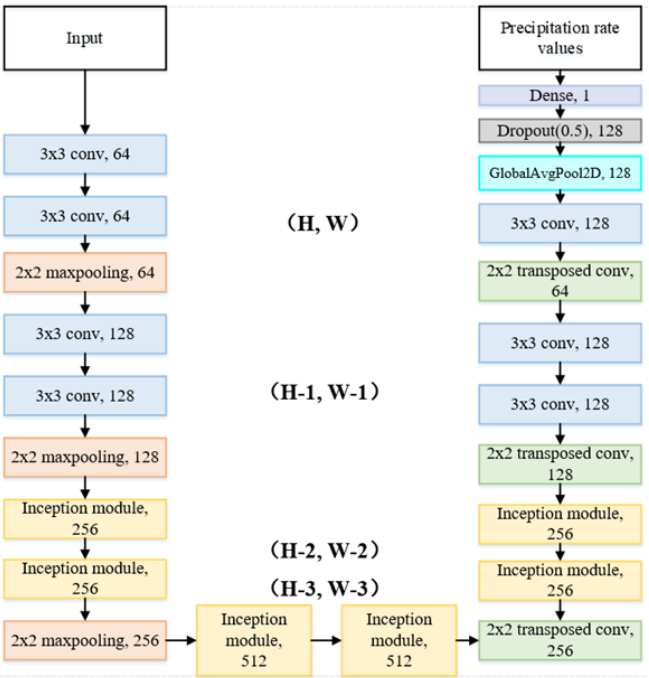
Figure 4. Detailed architecture of the proposed model. Each convolutional layer is followed by a batch normalization layer, and the ReLU is used as the activation function.